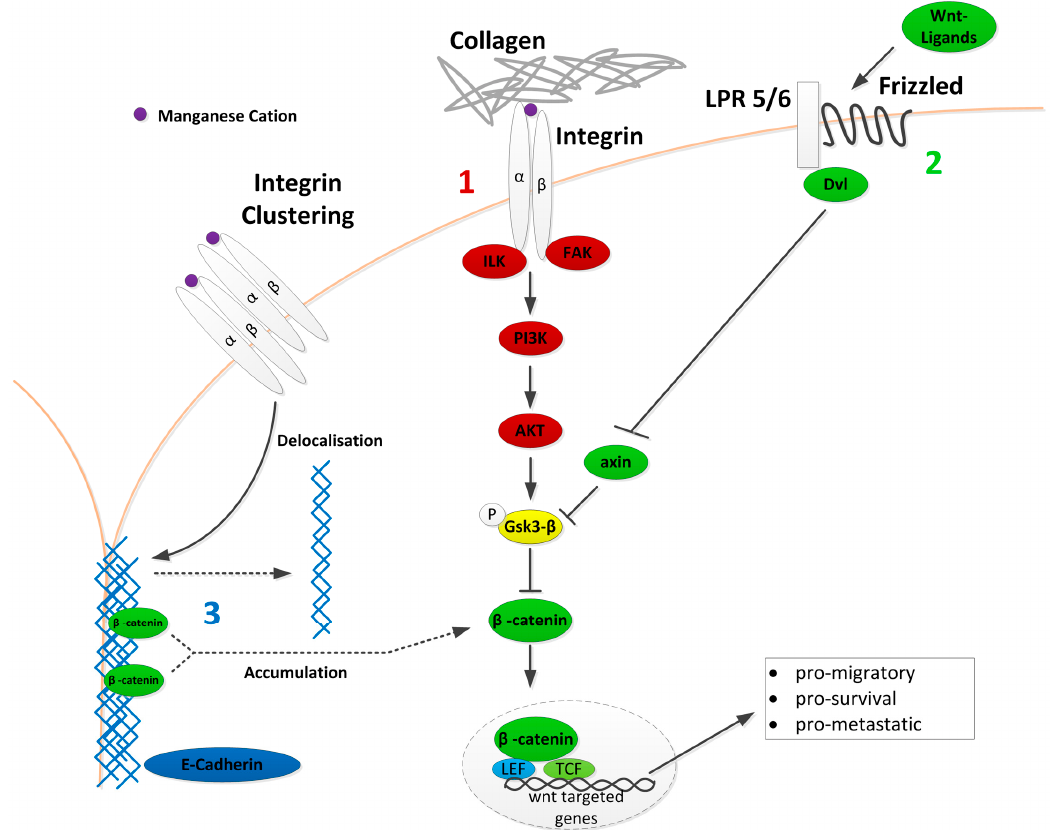
Figure 5. Crosslinks between integrin and wnt signalling. A schematic overview upon important steps of wnt signalling (green) and PI3K/AKT signalling (red) with Gsk3- β (yellow) as centrepiece connecting both pathways. The blue section highlights the involvement of E-cadherin delocalisation through integrin activation in β -catenin accumulation in the nucleus. Canonical wnt signalling begins with the connection between LPR 5/6 and Fzd leading to the recruitment of Dvl and deactivation of axin, which is no longer able to form the destruction complex, leading to Gsk3- β destabilisation. Active wnt signalling ultimately leads to the transcription of wnt-targeted genes that are known to transcribe into pro-migratory, pro-survival, and pro-metastatic factors. After integrin activation, a signalling cascade involving a multitude of proteins is activated, two of which are PI3K and AKT, whose main phosphorylation target is Gsk3- β , therefore, connecting the two pathways. Moreover, E-cadherin delocalisation, through integrin activation, has been shown to release β -catenin into the cytoplasm, where it can act as an effector on the wnt-pathway.